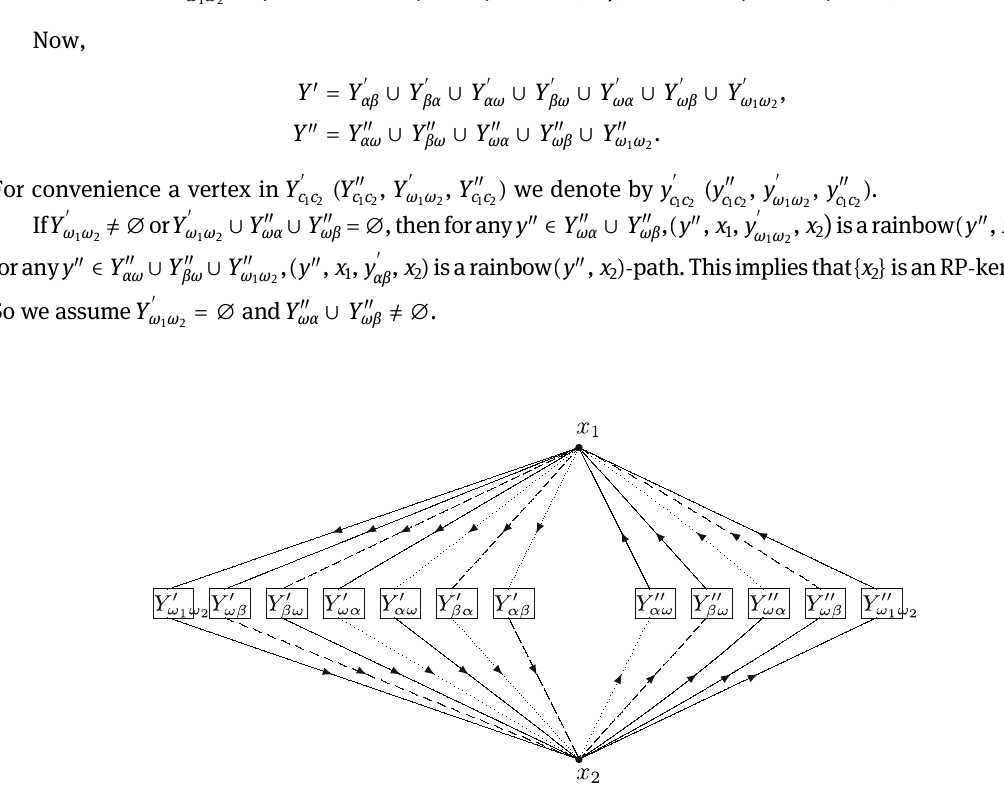
Figure 3: An arc - coloured bipartite tournament for Case 2 of the proof of Lemma